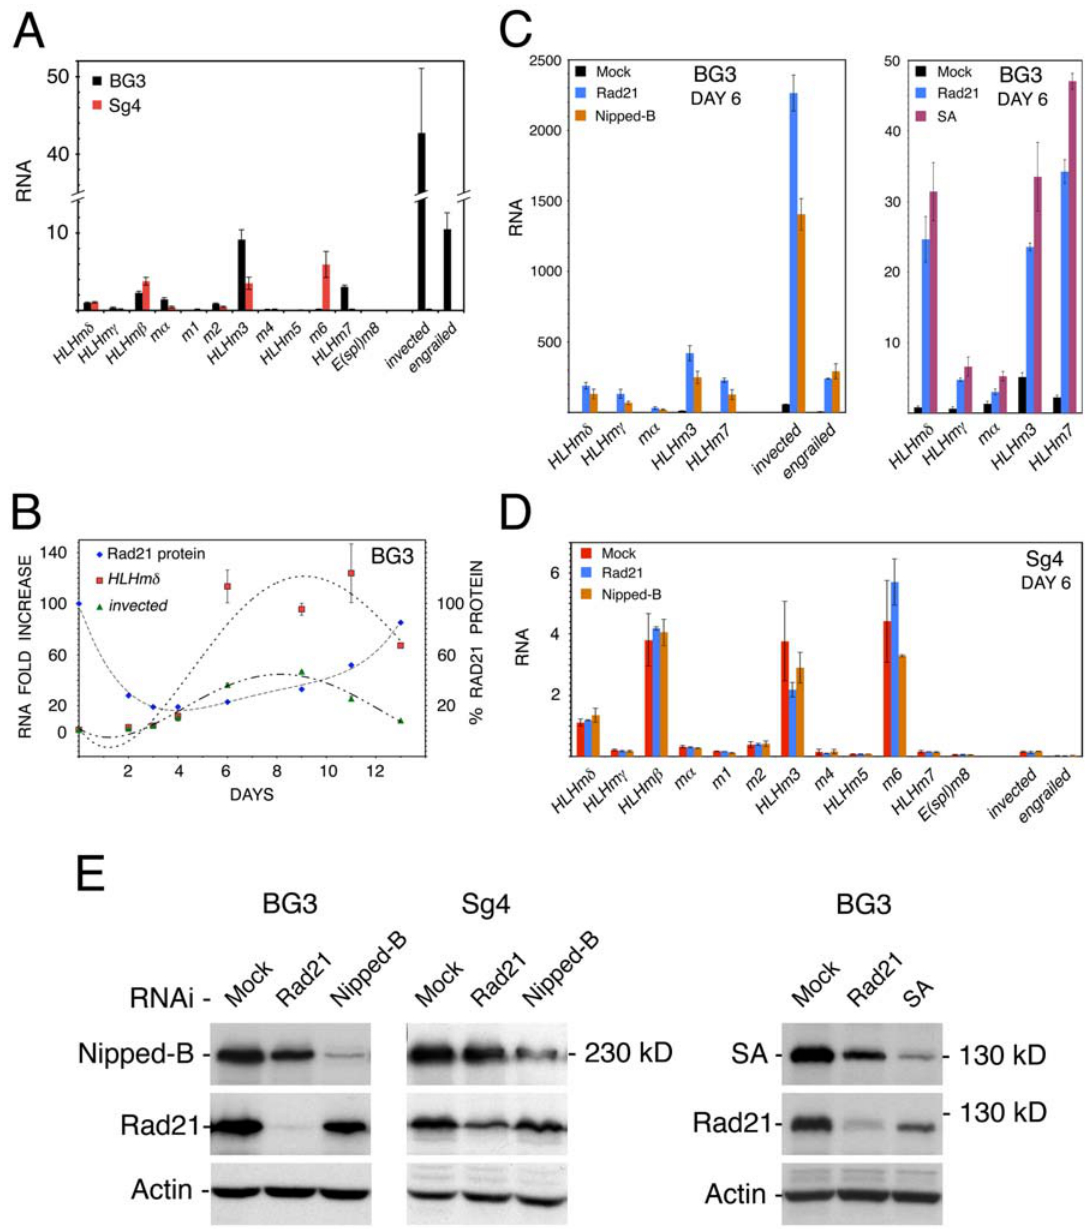
Figure 2. Regulation of the E(spl)-C and invected-engrailed complex by cohesin and Nipped-B. (A) Transcripts for the E(spl)-C and invected- engrailed complex in BG3 (black) and Sg4 (red) cells quantified by RT-PCR and normalized to RpL32 . The HLHm d level in BG3 cells is defined as 1 unit, and all transcripts are normalized to this value. By comparison to genomic DNA standards, HLHm d transcripts in BG3 cells are 8,400-fold less than RpL32 transcripts. BG3 values are the average of three RNA preparations, and Sg4 values are the average of two. Standard errors were calculated using all RT-PCR replicates from all biological replicates. (B) Rad21 RNAi time course, for Rad21 protein (blue diamonds, 100% starting), and fold- increases for the HLHm d (red squares) and invected (green triangles) transcripts. Similar time courses are seen for engrailed and other E(spl)-C transcripts (not shown). Nipped-B knockdown shows similar time courses in Nipped-B protein and E(spl)-C and invected-engrailed transcripts (not shown), except that some E(spl)-C transcripts decrease on day 3 (Figure 3). (C) The left panel shows transcript levels in a typical experiment with mock RNAi-treated BG3 cells (black) and BG3 cells six days after Rad21 (blue) or Nipped-B (orange) RNAi treatment. The right panel shows transcript levels in another experiment with mock-treated BG3 cells (black), and BG3 cells treated with Rad21 (blue) or SA (purple) RNAi six days after treatment. (D) E(spl)-C and invected-engrailed transcript levels in mock-RNAi treated Sg4 cells (red), or Sg4 cells after two successive 3 day Rad21 (blue) or Nipped-B (orange) RNAi treatments. (E) Western blots of whole cell extracts after RNAi treatment. The three left panels show the same blot of BG3 extracts six days after RNAi probed with Nipped-B, Rad21 and Actin antisera. RNAi treatments are indicated at the tops of the lanes. The middle three panels show a blot of Sg4 extracts after two successive 3 day RNAi treatments. The right panels show a blot of BG3 extracts probed with SA, Rad21 and Actin antibodies six days after RNAi.